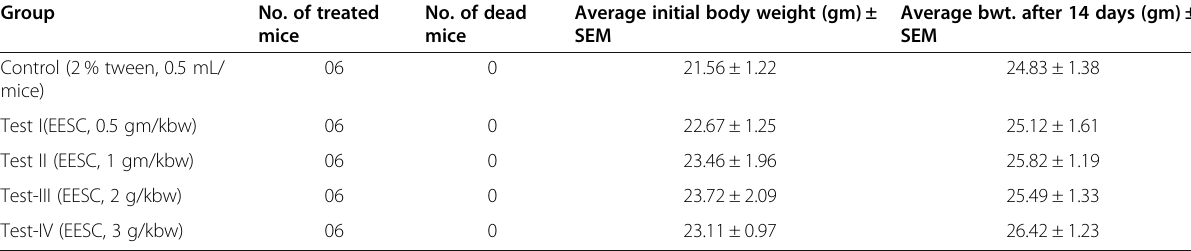
Values are expressed as mean ± standard error of mean ( n = 6) EESC Ethanolic extract of S. caseolaris (L.) Engl